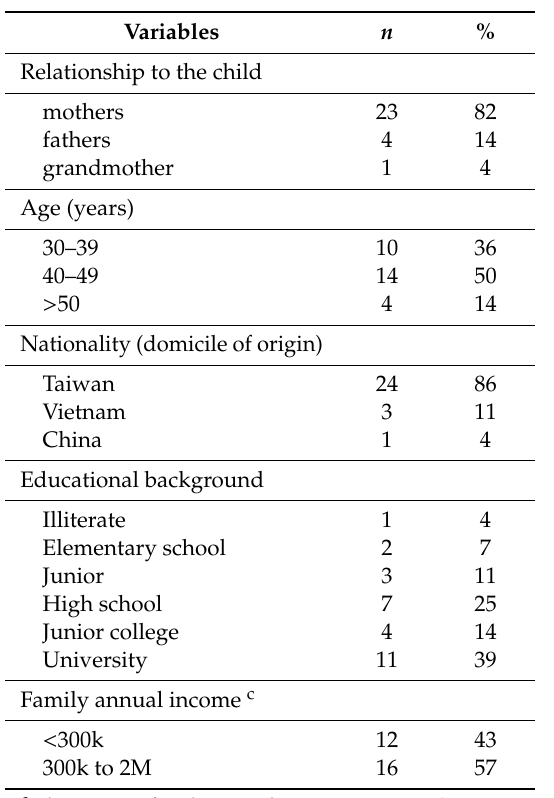
Table 2. Demographic information of parent respondents ( n =